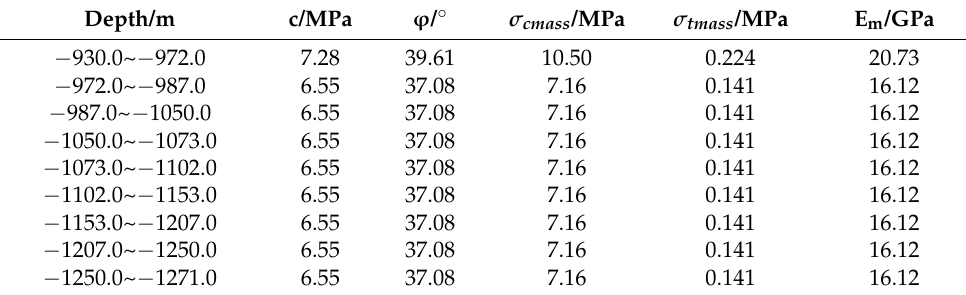
Table 6. Estimation results of rock mass strength parameters.